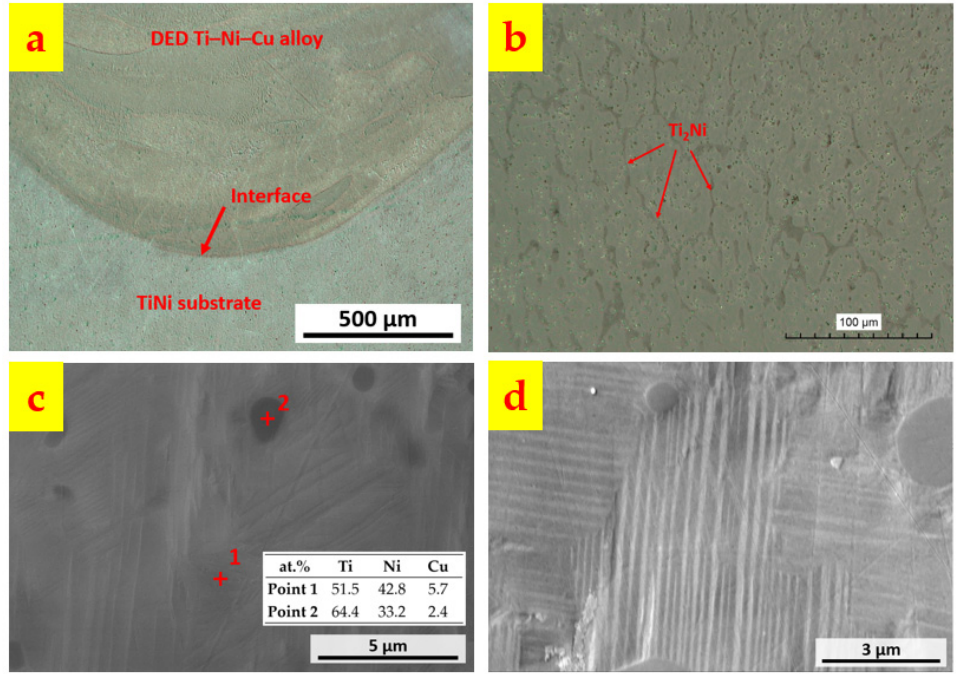
Figure 3. Microstructural features of the as-deposited Ti–Ni–Cu SMA. ( a ) Interfacial region between the DED Ti–Ni–Cu SMA and the TiNi substrate. ( b ) Microstructure of TiNi matrix and Ti 2 Ni. ( c ) EDS point analysis of TiNi matrix and Ti 2 Ni. ( d ) Twinning structure of martensitic TiNi phase.